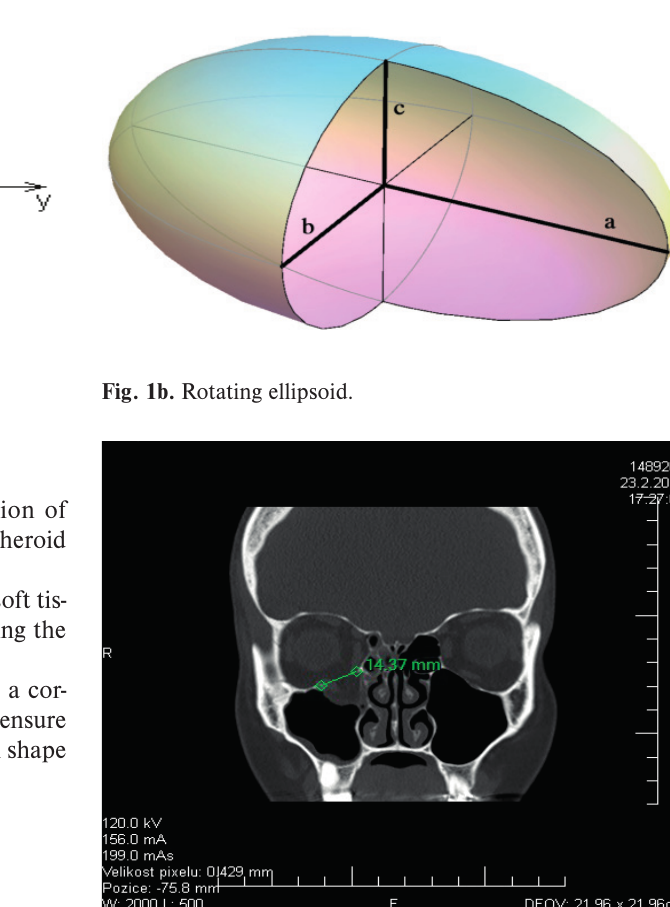
Fig. 2. Measurement through coronal.